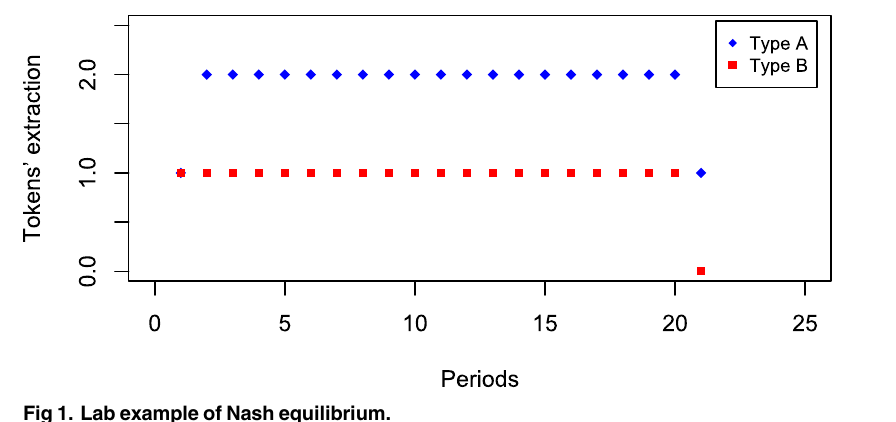
Fig 1. Lab example of Nash equilibrium.